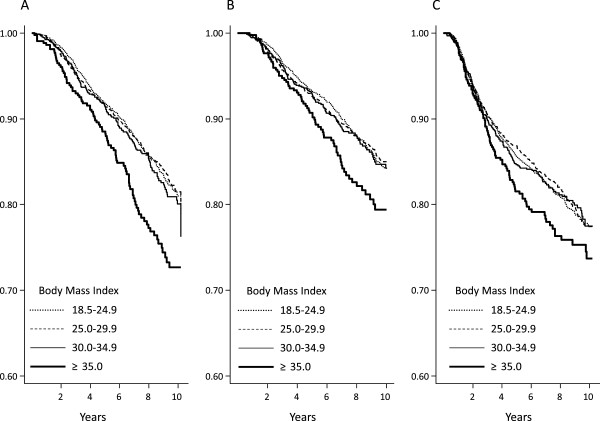
Crude Kaplan-Meier curves for each survival outcome for each body mass index (BMI) category. (A) Overall survival. The lower curve shows patients with BMI ≥35. Overall log-rank P = 0.002; log-rank comparing the curve for BMI ≥35 with the rest was <0.001. (B) Breast cancer survival. The lower curve shows patients with BMI ≥35. Overall log-rank P = 0.052; log-rank comparing the curve for BMI ≥35 with the rest = 0.006. (C) Recurrence-free survival. The lower curve shows patients with BMI ≥35. Overall log-rank P = 0.226; log-rank comparing the curve for BMI ≥35 with the rest = 0.040.